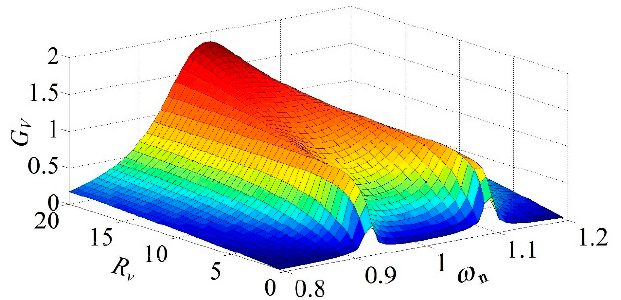
Figure 9. Voltage gain G V vs. R SC and ω n .